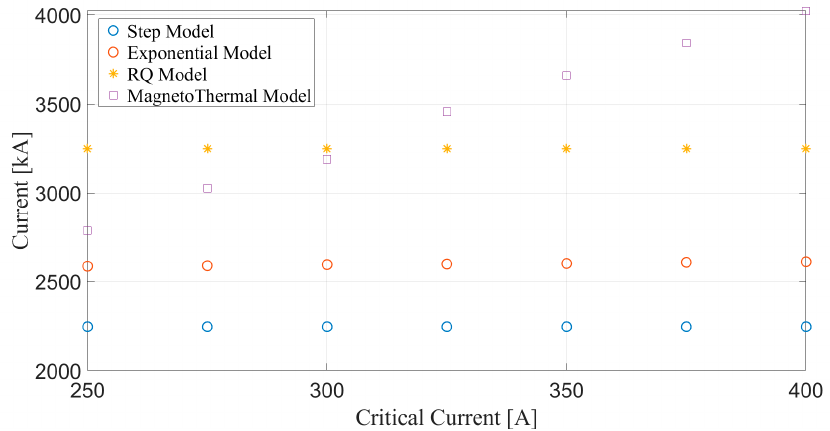
Figure 16. Peak current comparison for different critical current values and 5 Ω fault resistance.